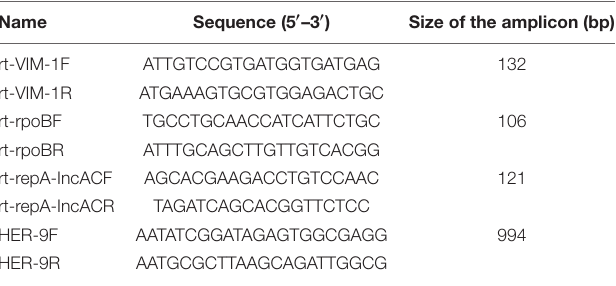
TABLE 1 | Nucleotide sequences of primers used for amplification and sequence